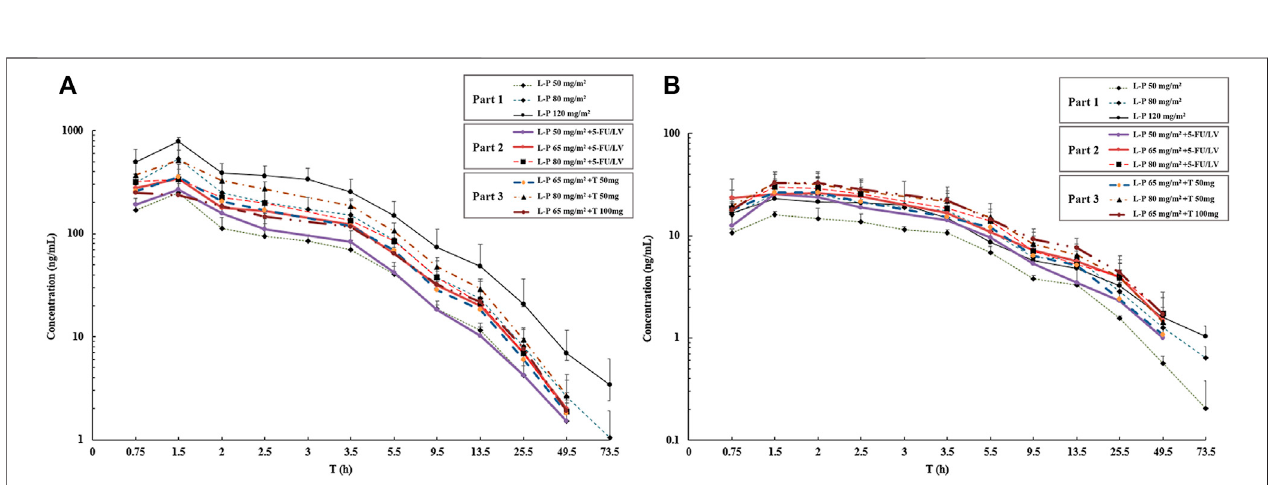
FIGURE 3 | Mean logarithmic concentration vs time plot of simmitecan (A) and chimmitecan (B) following infusion of simmitecan as a single agent (Part 1) and in combination with 5- fl uorouracil/leucovorin (Part 2) or thalidomide (Part 3). L-P, simmitecan; 5-FU/LV, 5- fl uorouracil/leucovorin; T, thalidomide.